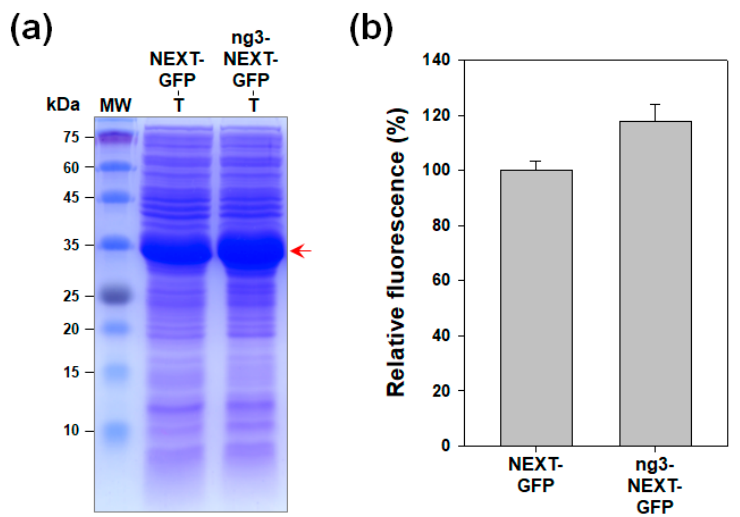
Figure 4. Effect of fusion of the ng3 sequence on the expression level of NEXT-GFP. ( a ) Expression analysis by SDS-PAGE followed by Coomassie blue staining. The arrow indicates the band position of recombinant proteins. Lanes: MW, molecular mass marker; T, total cell lysate. ( b ) Relative GFP fluorescence of whole-cell lysates. Error bars represent standard deviations from triplicate